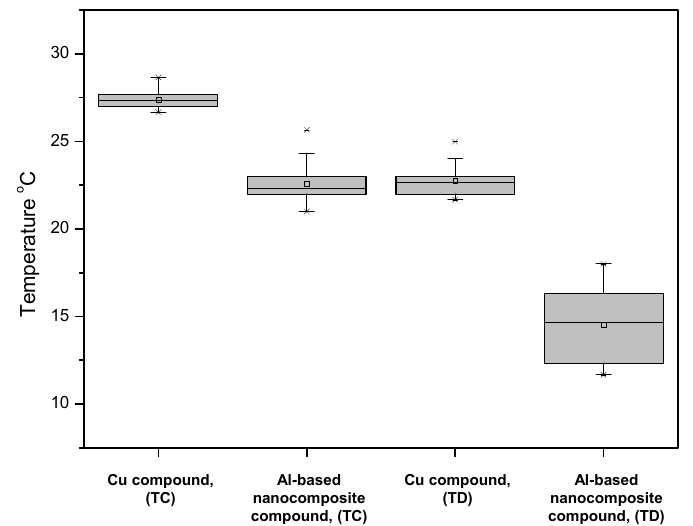
Figure 7. MCCB device temperature operating at 80% rated current monitored at terminals TC and TD of the device configuration.